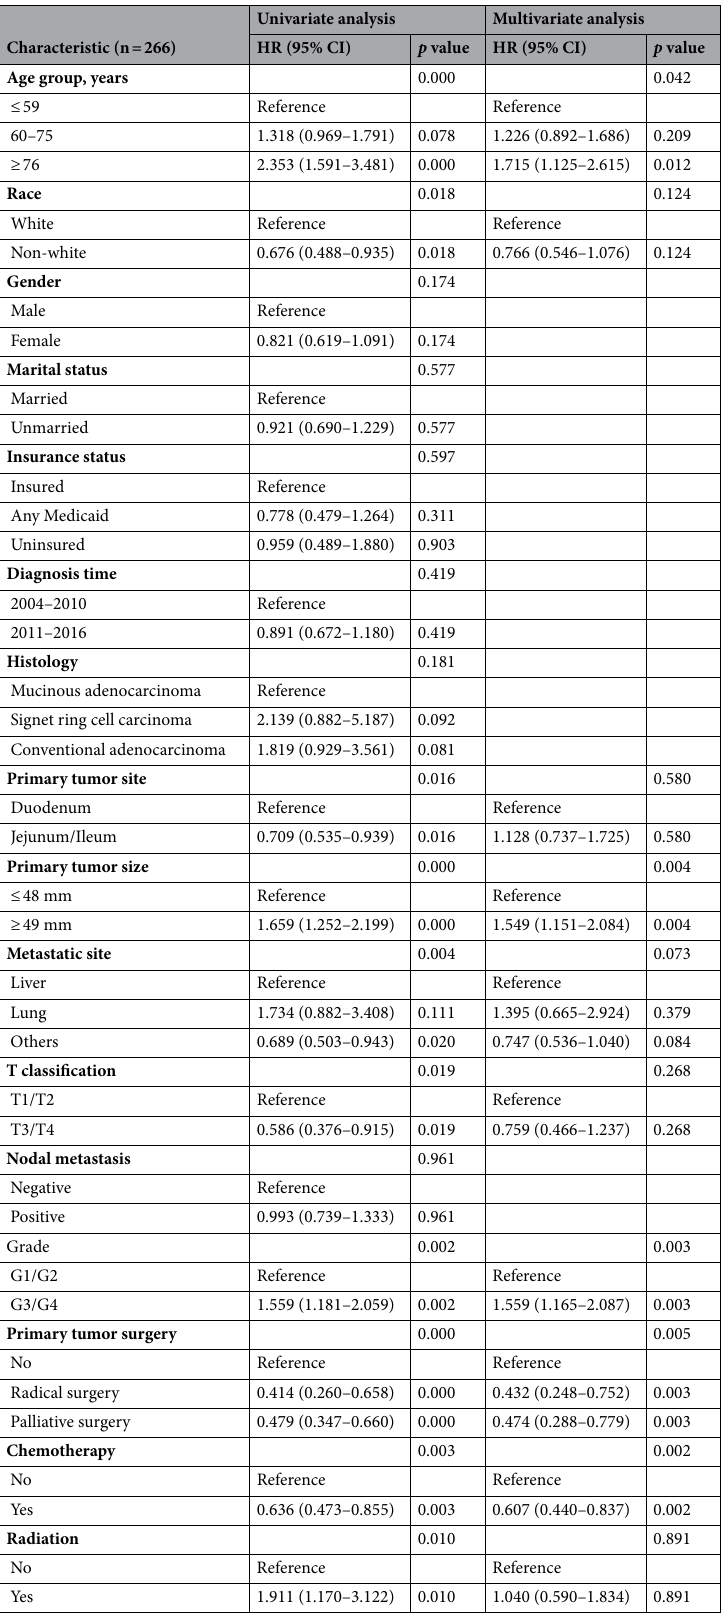
Table 3. Univariate and multivariate analyses of cancer-specific survival for the training cohort. Others*: bone, brain, distant lymph node, and other sites; HR, hazard ratio; CI, confidence